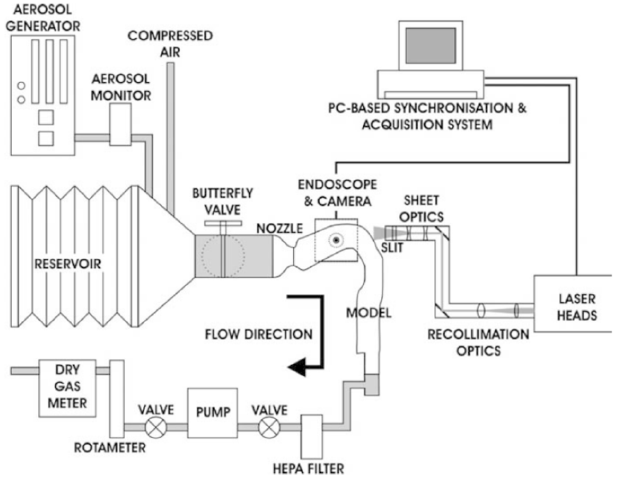
Figure 7. PIV experimental setup Reprinted with permission from Ref. [45]. 2003, A. F. Heenan et al.